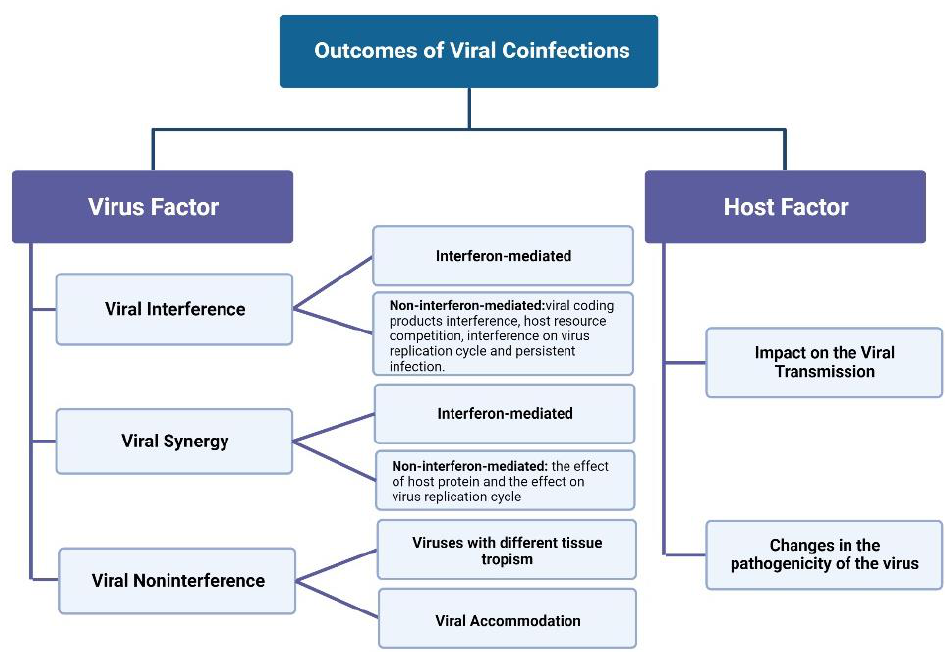
Figure 2. Outcomes of Viral Coinfections.